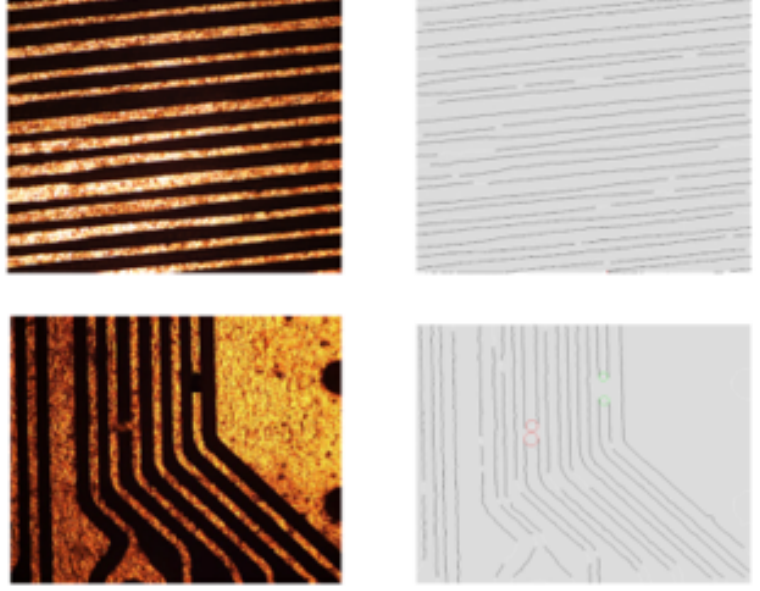
Figure 5. Line test results in actual